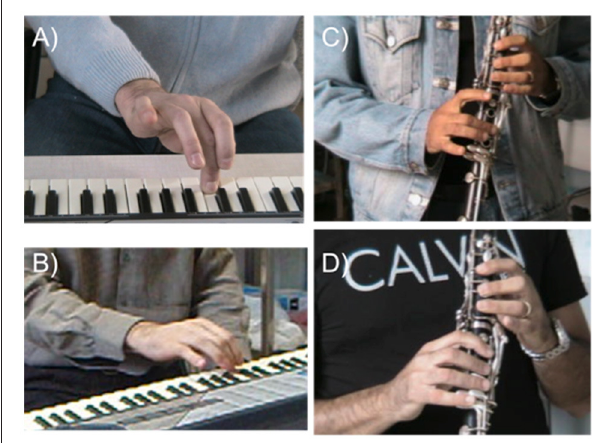
FIGURE 5 | Typical patterns of dystonia posture in a pianist (A) and clarinet (C) at baseline (T0). In (B,D) the patients after 5-days of C-tDCS